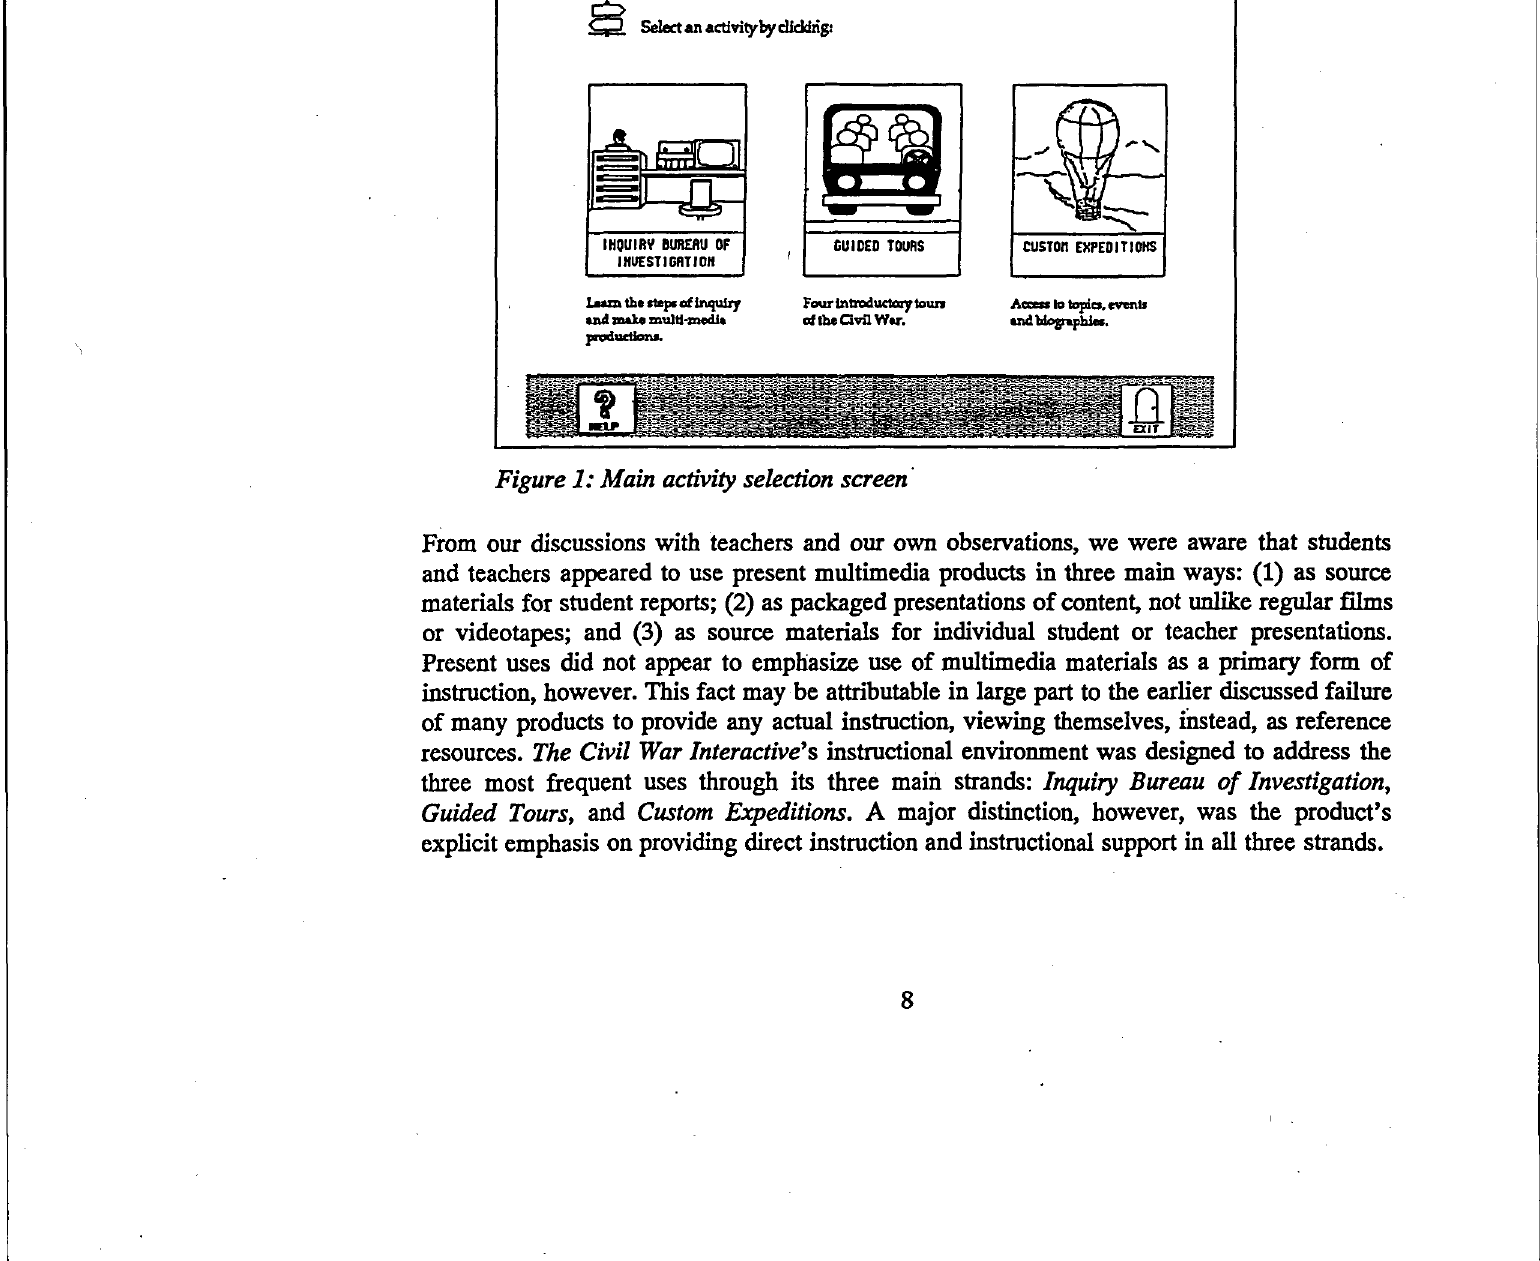
Figure 1: Main activity selection